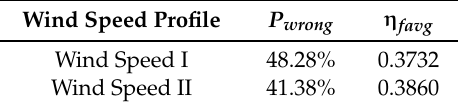
Table 2. ATG control performances under wind speeds I and II.